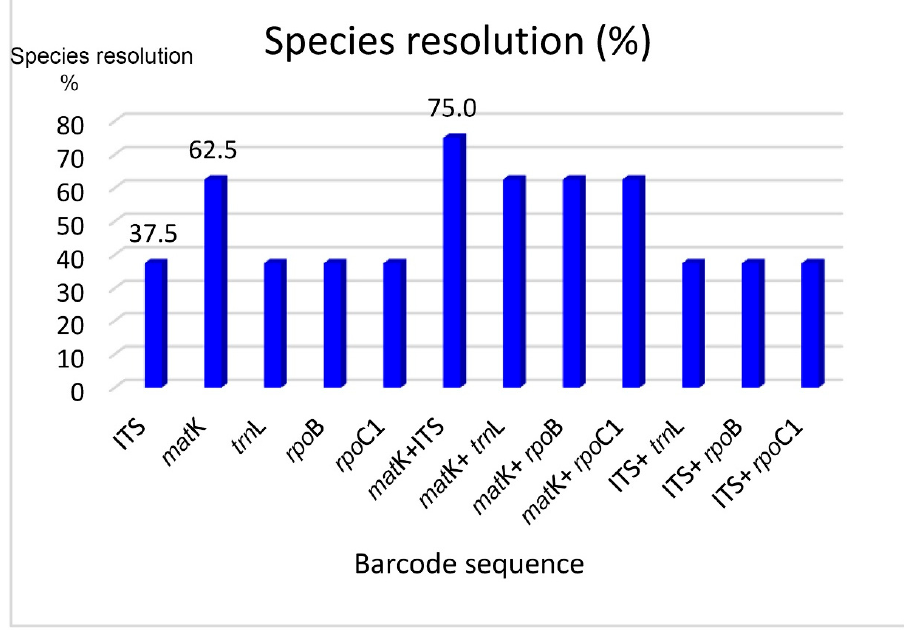
Figure 1. Species resolution results on eight Paphiopedilum endemic species (dataset I).